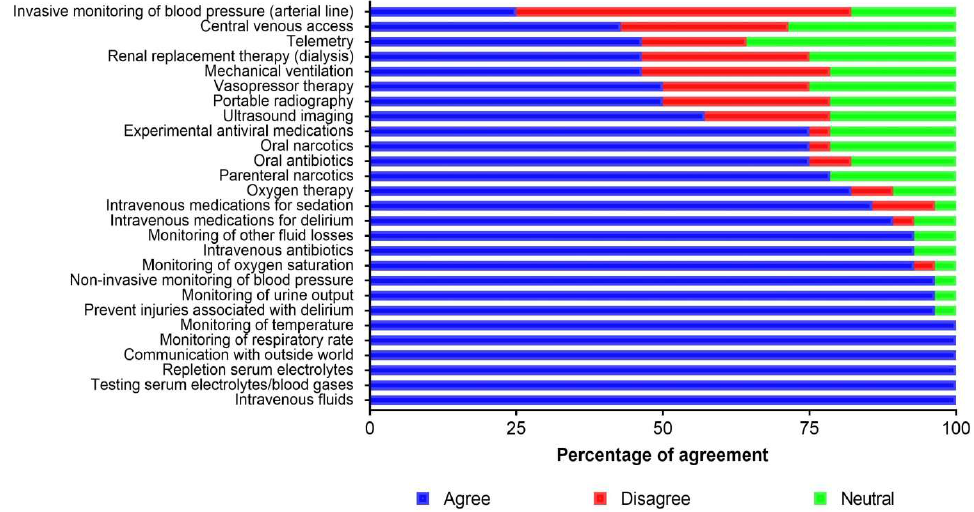
Figure 3. Agreement with supportive care interventions proposed to be embedded within standard practices in Ebola treatment units.